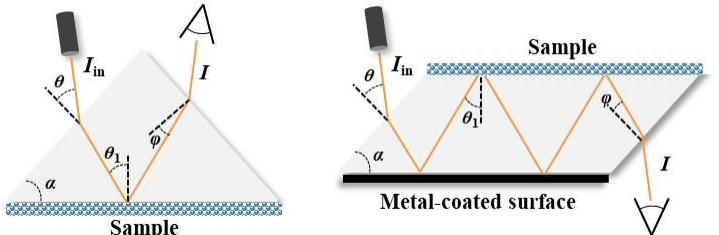
Figure 1. Prism ( left ) and parallel plate ( right ) configurations, the latter shown N = 2 reflections at the sensing